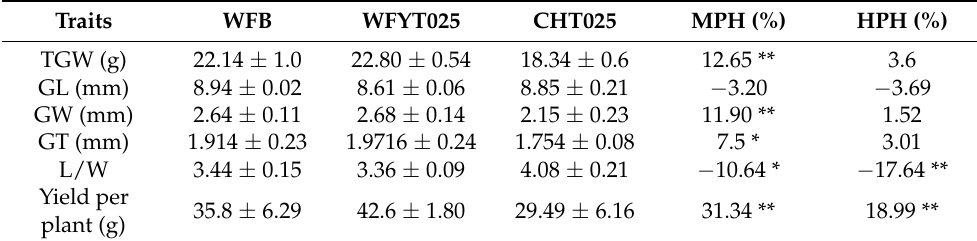
Table 1. Phenotype analysis of super-hybrid rice WFYT025 combination.